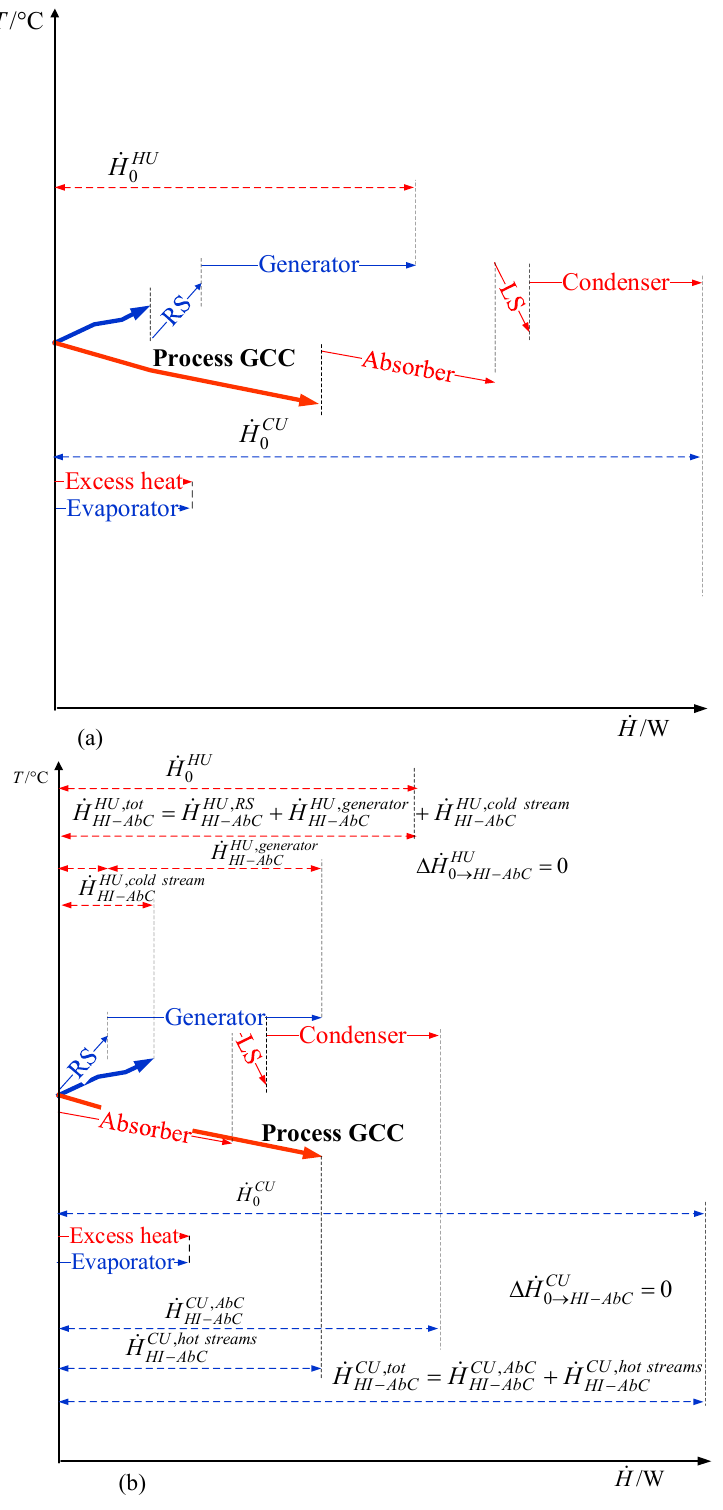
Figure 9. ( a ) Non-integrated and ( b ) integrated case of AC-process system when process heat demand is small.